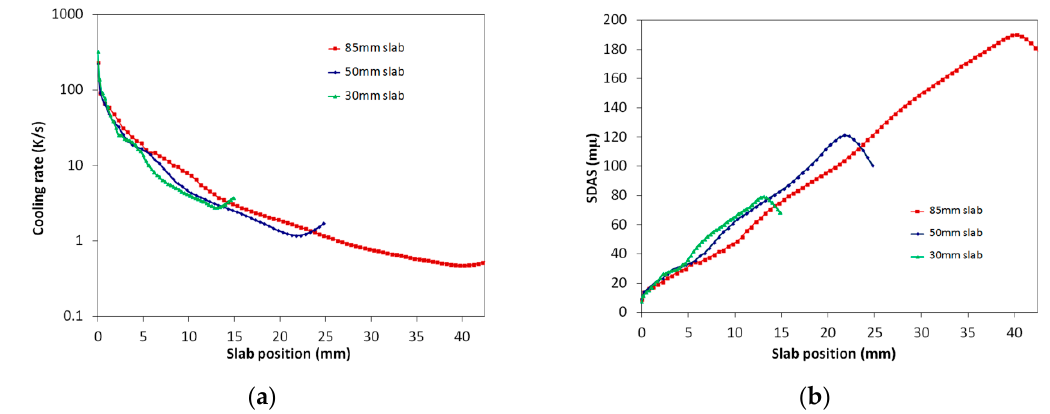
Figure 7. CON1D V7.0 slab casting heat transfer model predicted: ( a ) cooling curves; and ( b ) secondary dendrite arm spacing (SDAS) at different positions of 30, 50, and 85 mm slabs.